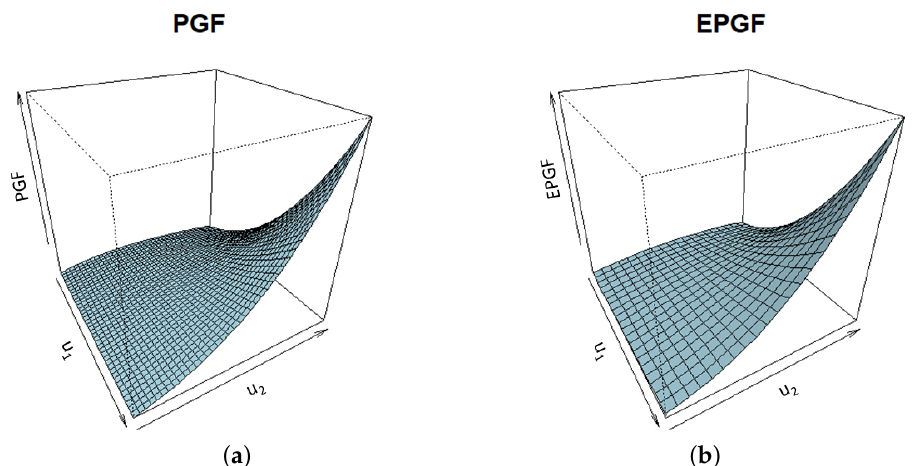
Figure 2. 3D plots of the two-dimensional PGF ( a ) and the corresponding EPGF ( b ) innovations are the ZOIPS series with a geometric PS distribution. (Parameters values are θ = α = 0.5, φ 0 = φ 1 =